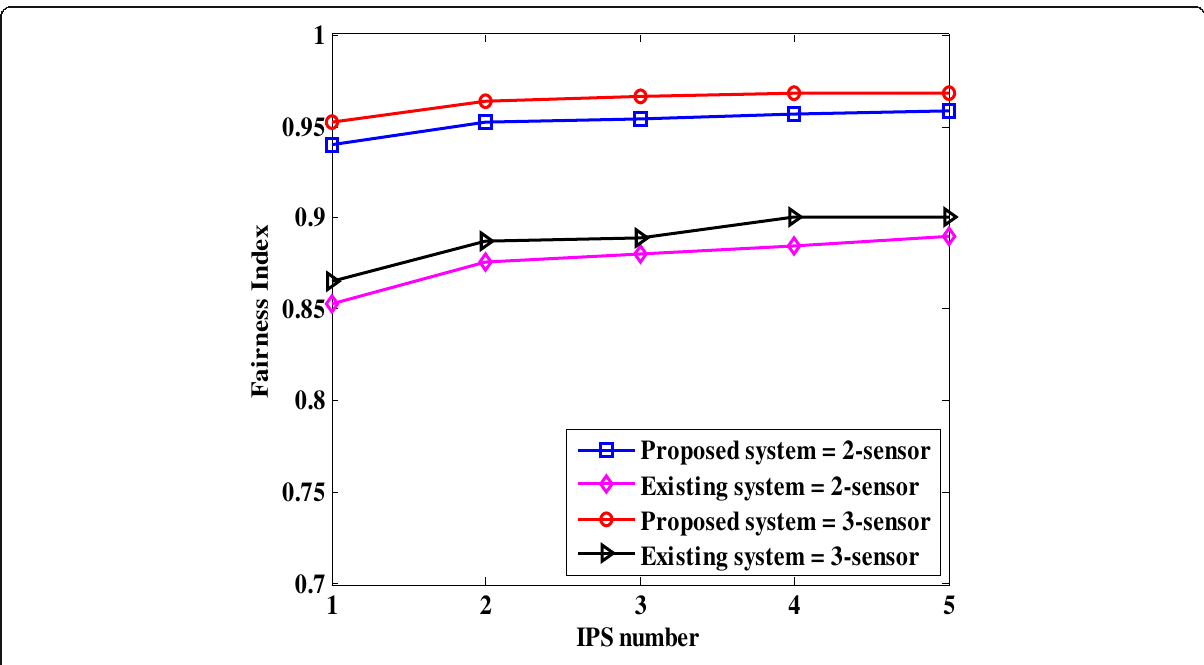
Fig. 7 System fairness against IPS number